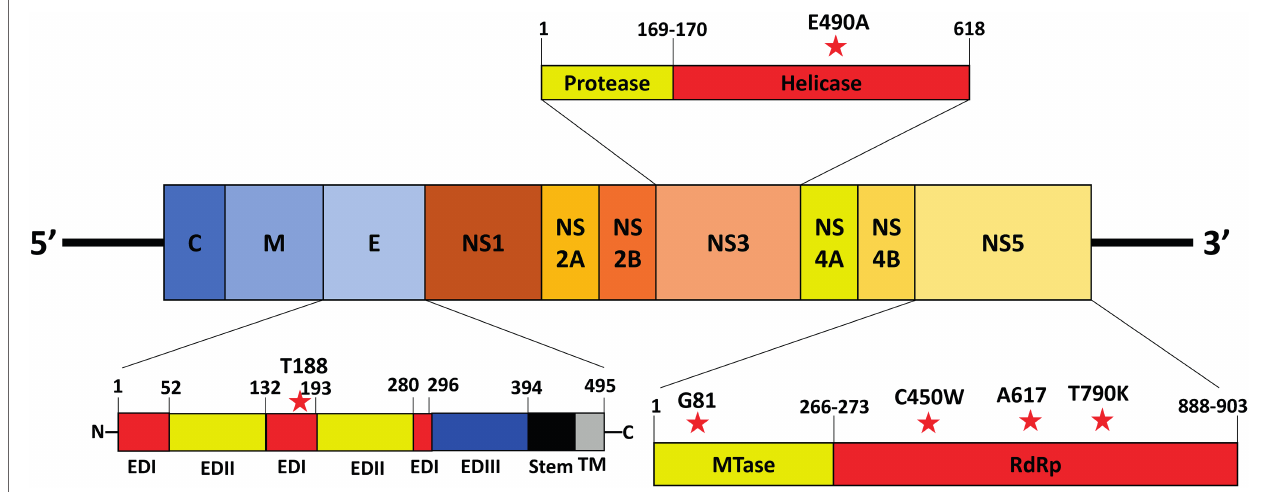
FIGURE 2 | Location of nucleotide variations in virus genome. The location of the nucleotide variations within the DENV viral genome. The red stars represent the variations on the virus genome.